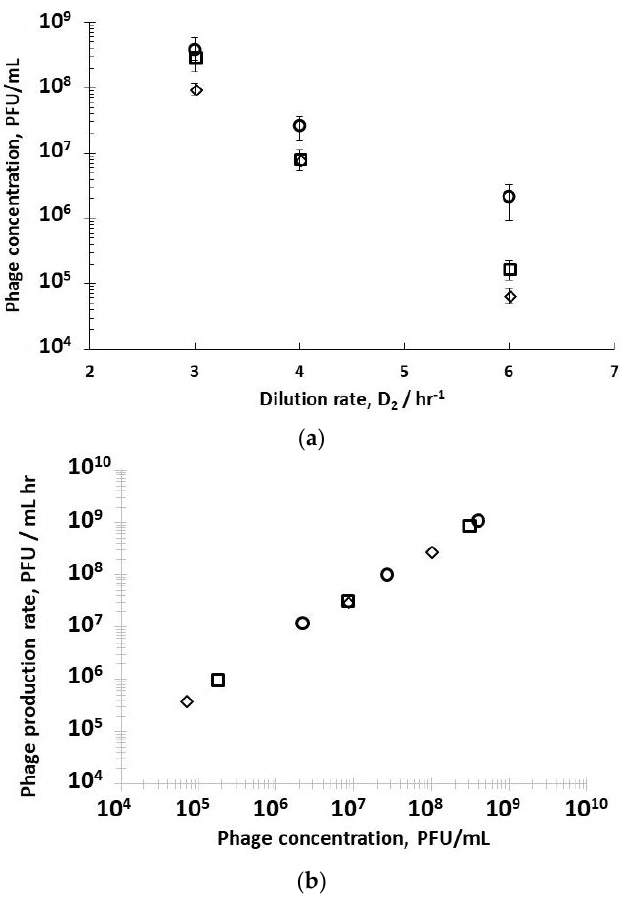
Figure 4. ( a ) The effect of bacteria physiology and dilution rate D 2 on phage titres in the second reactor R2. ( b ) Phage production rate as a function of phage concentration in R2. Open squares (□) correspond to phages produced in R2 when R1 was operated at D 1 = 0.4 hr − 1 ; open round circles (o) correspond to phages produced in R2 when R1 was operated at D 1 = 0.5 hr − 1 ; open diamonds ( ♦ ) correspond to phages produced in R2 when R1 was operated at D 1 = 0.6 hr − 1 . Error bars represent one standard deviation.